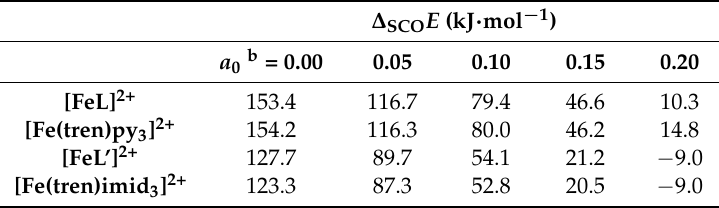
Table 4. Functional scan of apparent SCO energies of iron(II) complexes from Scheme 1.